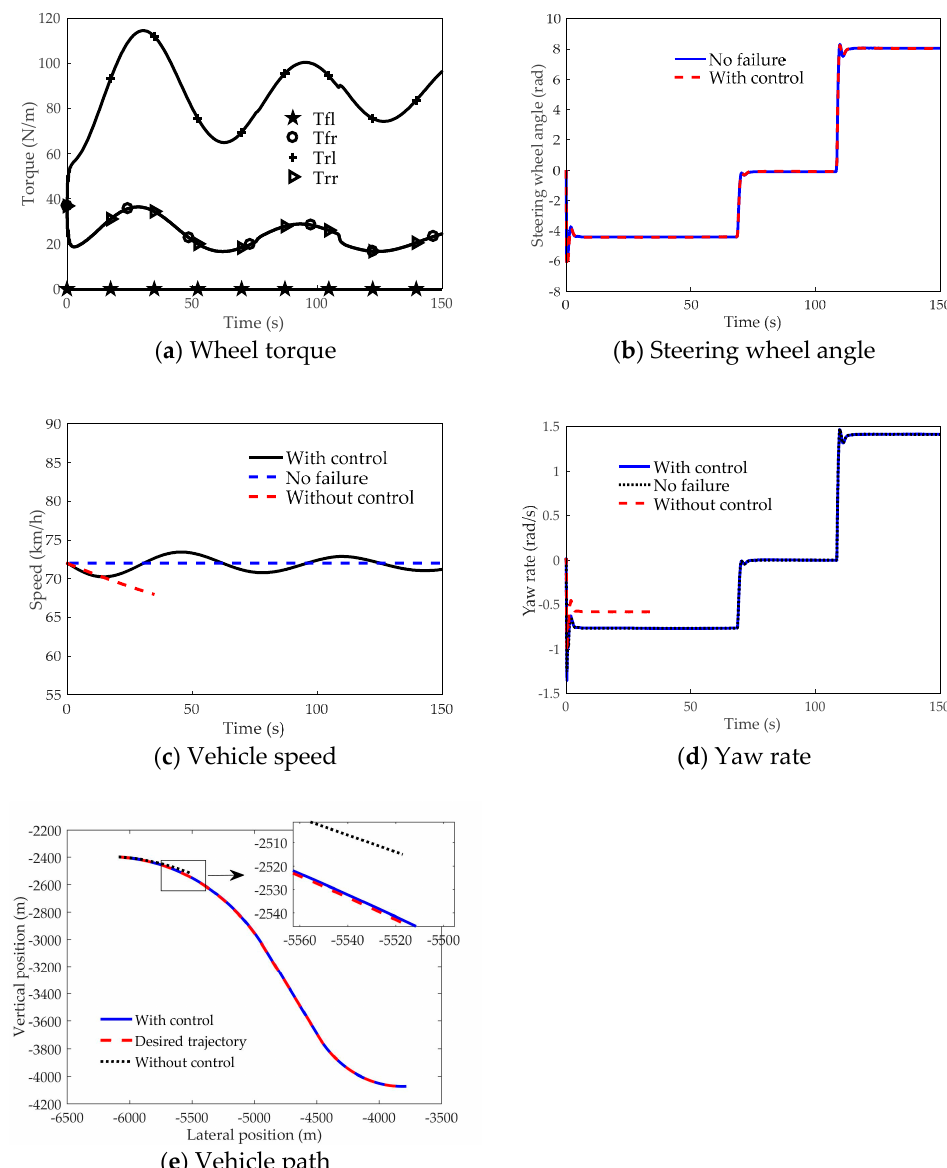
Figure 5. Simulation comparison with/without control under F3 condition. Table 8. Statistical control effect under F3 condition.